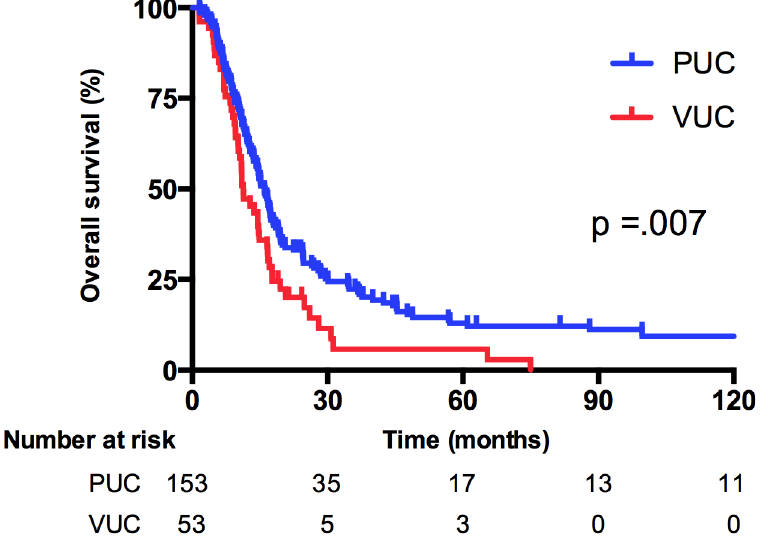
Fig 2. Overall survival (OS) stratified by variants of urothelial carcinoma (VUC) or pure urothelial carcinoma